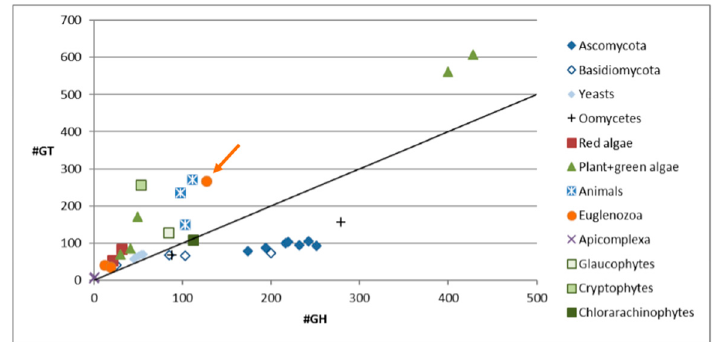
Figure 1. The number of carbohydrate active enzymes annotated in the genomes of selected organisms. Most organisms have more glycosyltransferases than glycoside hydrolases, except amongst the saprophytic fungi and oomycetes. Euglena gracilis is indicated with an arrow. See Table S1, Supplementary Materials for a breakdown of the CAZyme families encoded in the Euglena transcriptome.